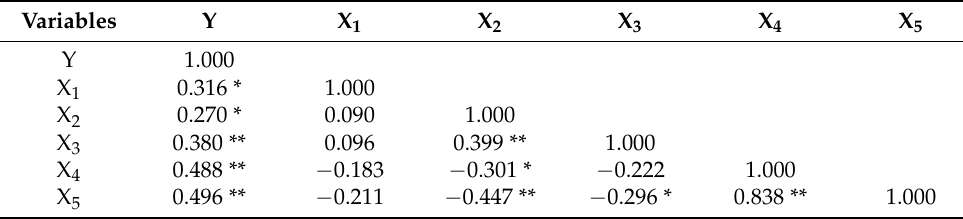
Table 3. Correlation coefficients of dependent (y) and independent (x)